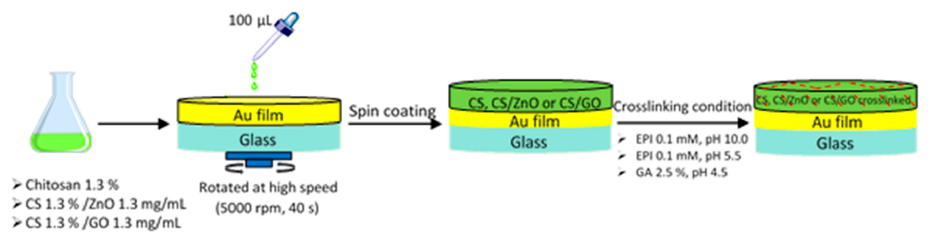
Figure 2. Schema of the preparation procedure for SPR sensor with di ff erent experimental